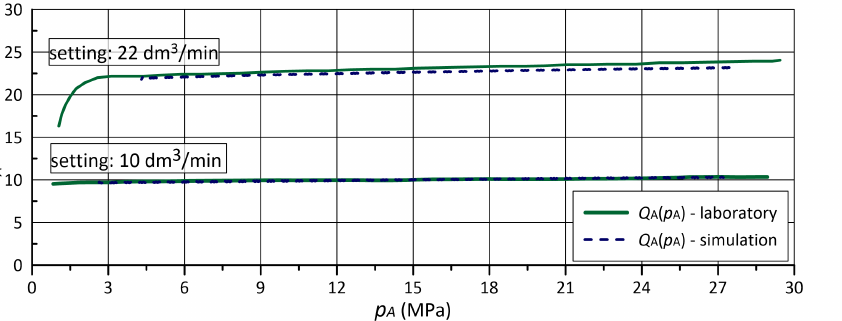
Figure 19. Comparison of the p - Q characteristic: solid—experimental curves, dashed—simulation results.